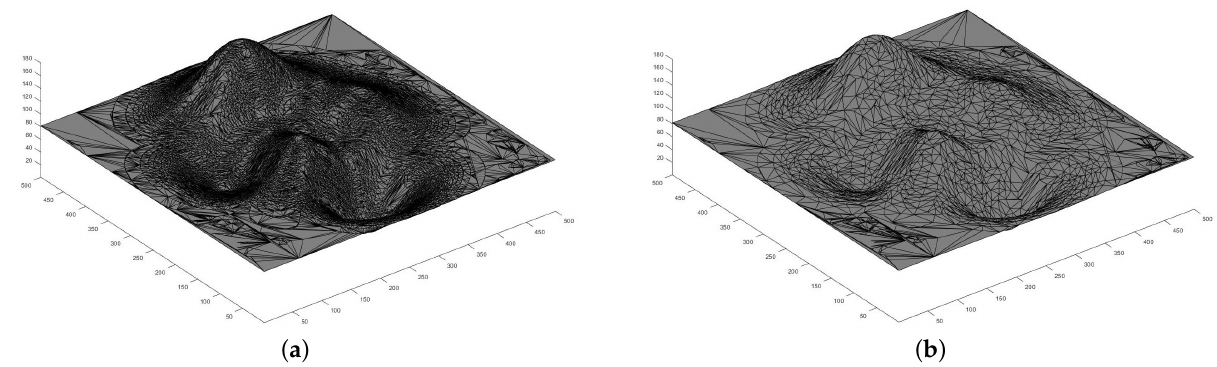
Figure 2. The results of the terrains’ simplification: ( a ) the terrain before simplification, and ( b ) the terrain after simplification.